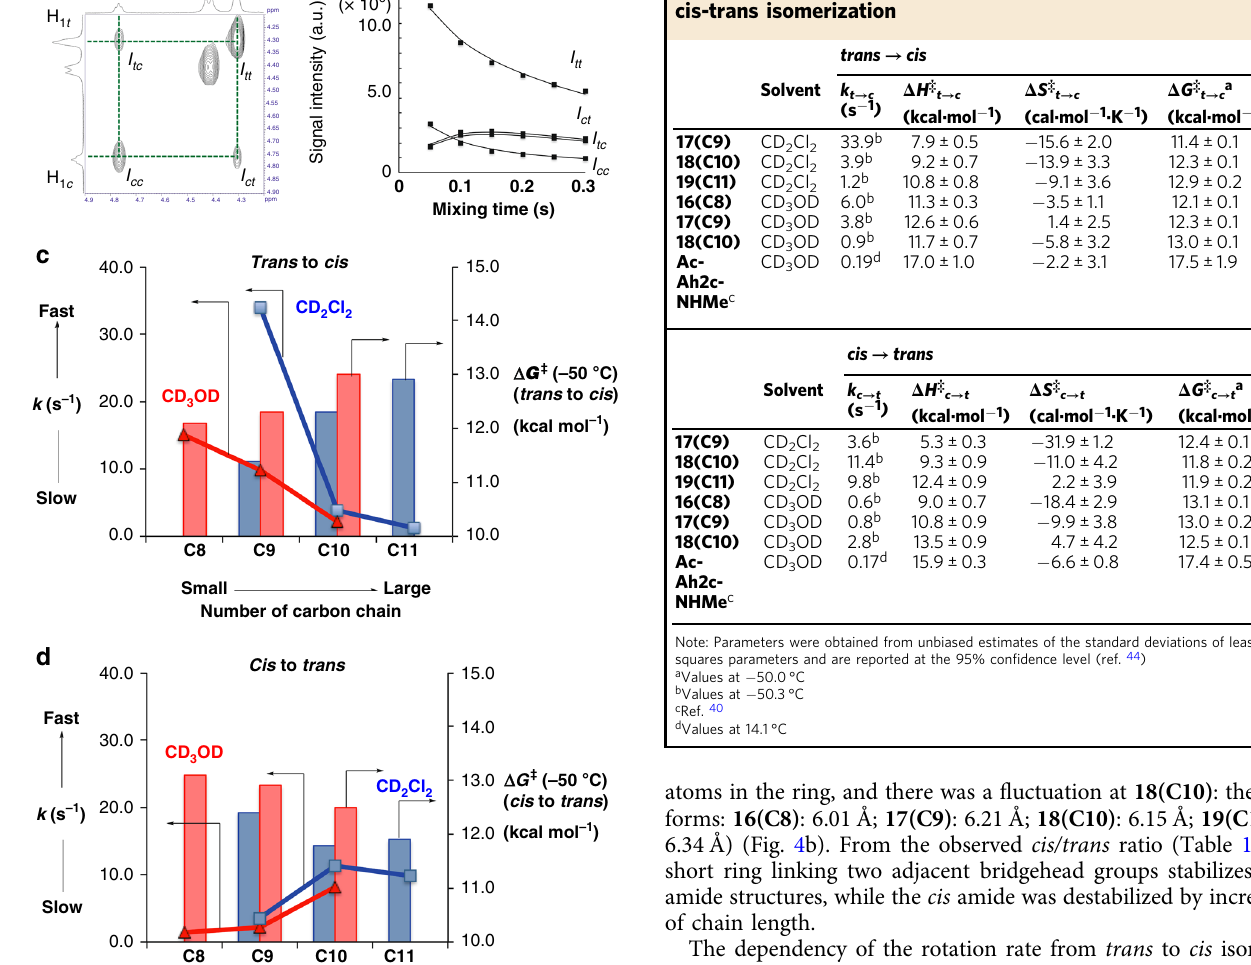
(C10) ( d 17(C9) ( d O-O : 6.15 Å) as compared with O-O : 6.21 Å), in